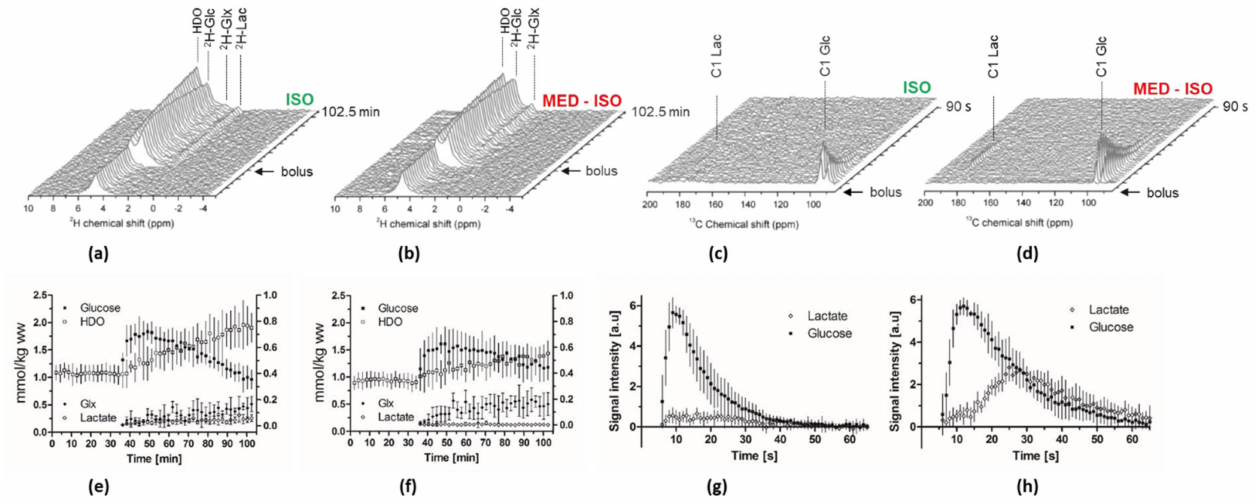
Figure 2. ( a , b ) Characteristic dynamic spectra measured in the mouse head under the two different anesthetic protocols. (‘ISO’ or ‘MED–ISO’) following infusion of non-HP [6,6 (cid:48) - 2 H 2 ]Glc and the corresponding time courses of water (HDO), Glc ( 2 H-Glc), glutamate–glutamine ( 2 H-Glx) and lactate ( 2 H-Lac) shown for each group ( e , f ) respectively, mean ± SD. HDO and Glc refer to the left y-axis while Glx and Lac refer to the right y-axis. ( c , d ) Characteristic spectra measured in the mouse head under the two different anesthetic following infusion of HP [ 2 H 7 , U- 13 C 6 ] Glc and the corresponding time courses of [1- 13 C] Lactate and [1- 13 C]glucose shown for each group ( g , h ), mean ± SD; glucose signal normalized to 6, arbitrary